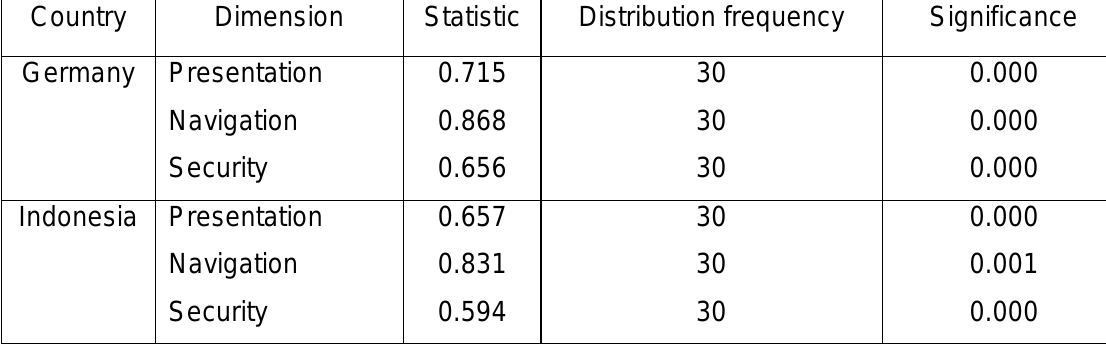
Table 2. The Shapiro-Wilk Test